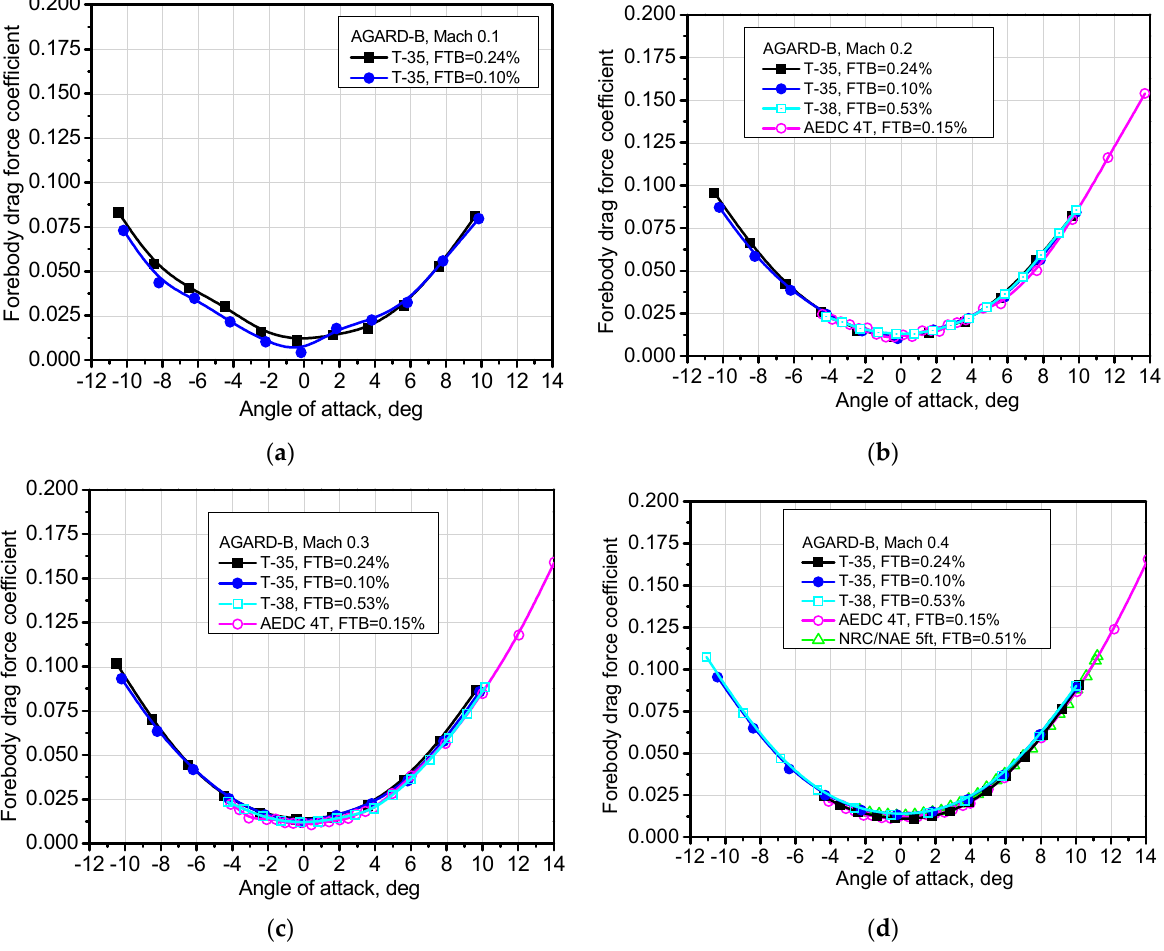
Figure 12. Inter-facility correlation in the forebody drag force coefficient of the AGARD − B model [28,33,44].